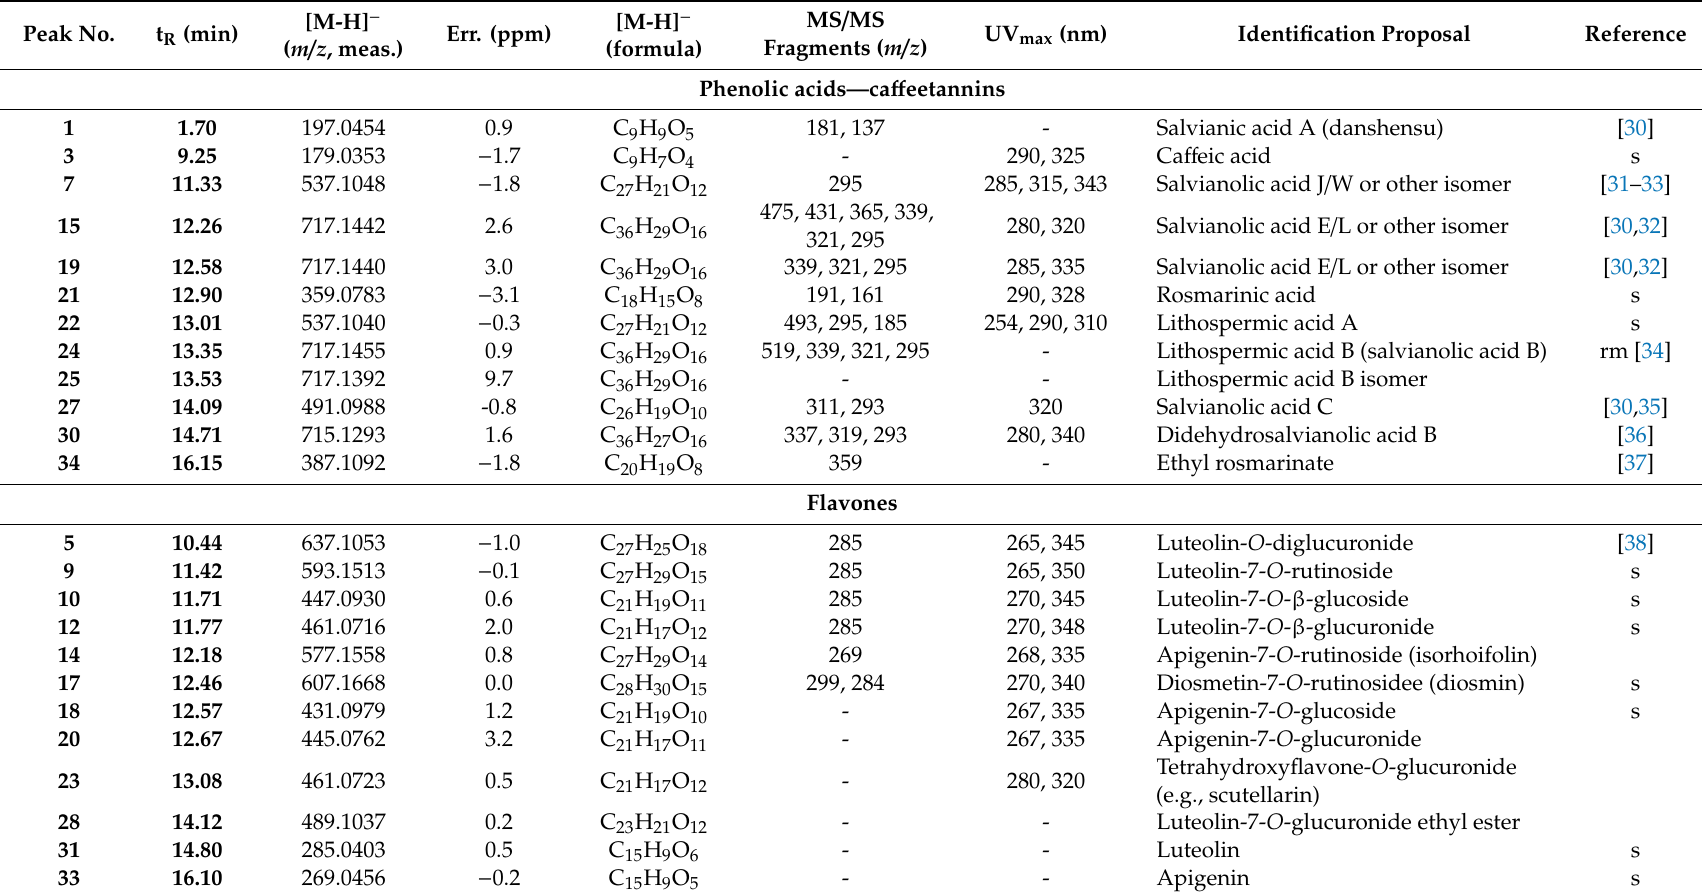
Table 1. LC-HRMS, UV-Vis, and MS / MS properties of compounds identified in peppermint tinctures. Peak